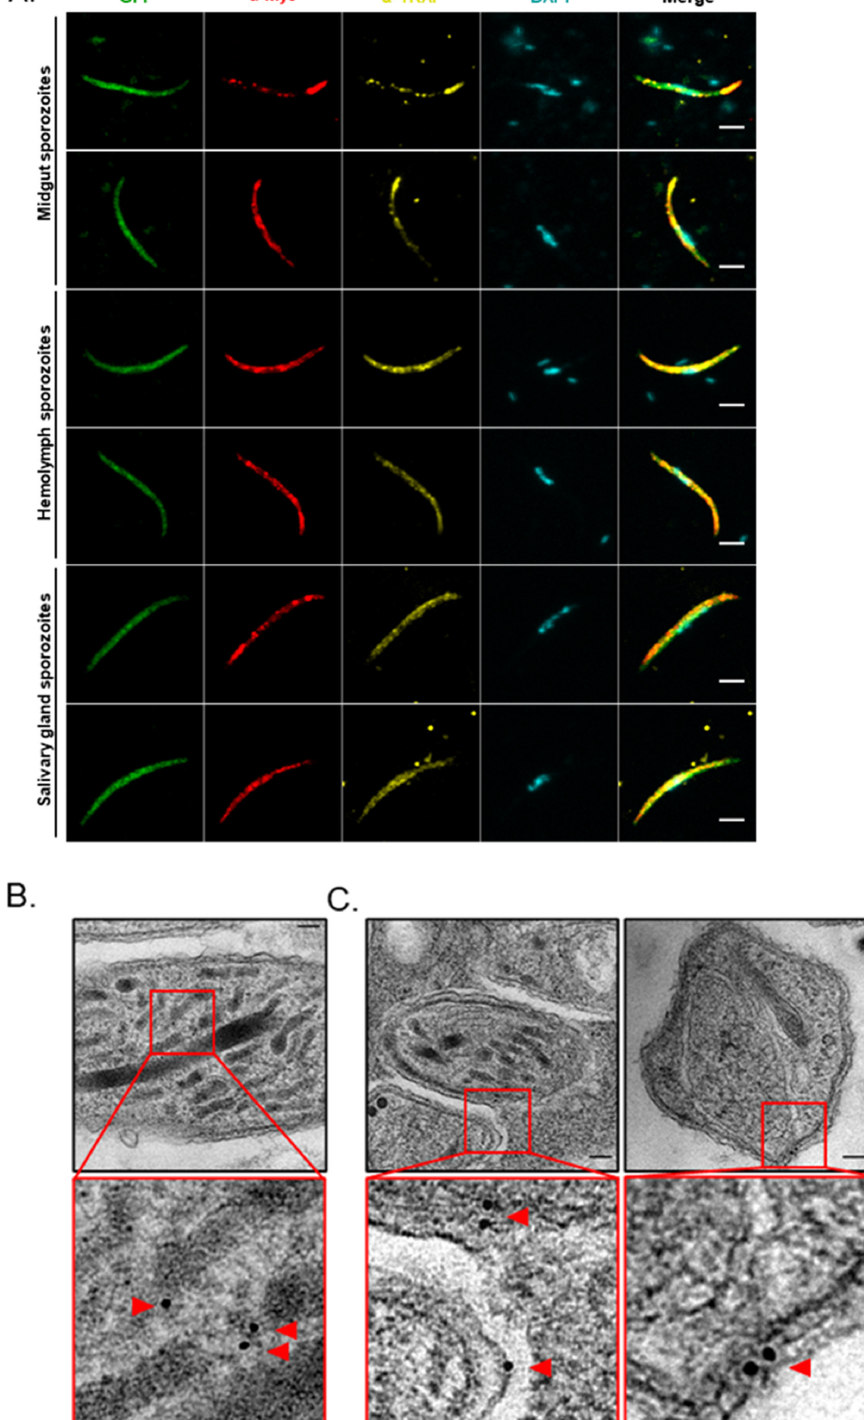
Figure 7. Localization of myc-tagged MAEBL in sporozoites. ( A ) Immunofluorescence analysis of myc-tagged MAEBL distribution by confocal microscopy. maebl:myc sporozoites were collected on day 18 (for midgut and hemolymph sporozoites) and day 20 (for salivary glands sporozoites) post-